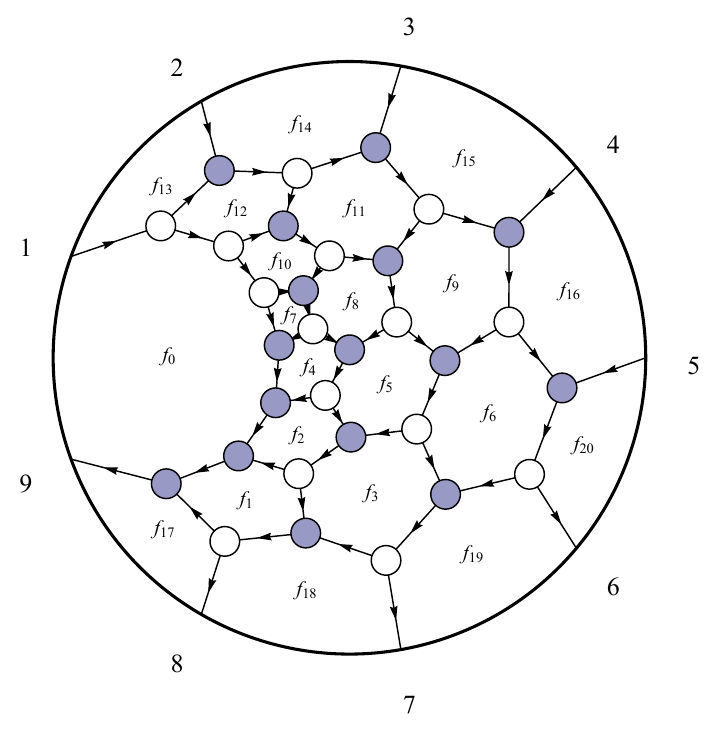
Figure 2 . A plabic graph associated to the top cell of G + (5 , 9)